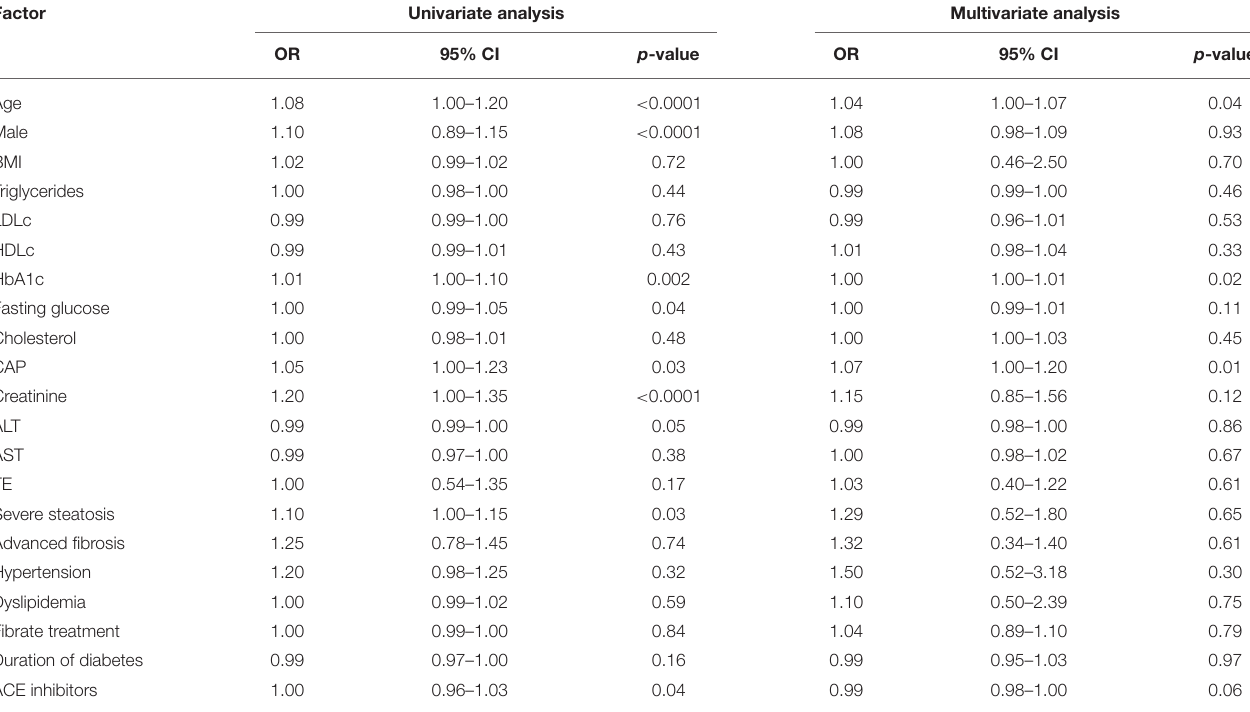
TABLE 3 | Univariate and multivariate logistic regression analysis of factors associated with CKD. Factor Univariate